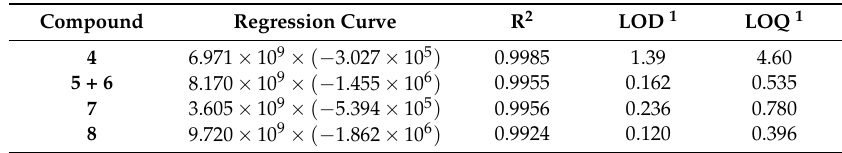
Table 1. Regression curves, coefficients of determination, limit of detection (LOD), and limit of quantitation (LOQ) of the UHPLC method.